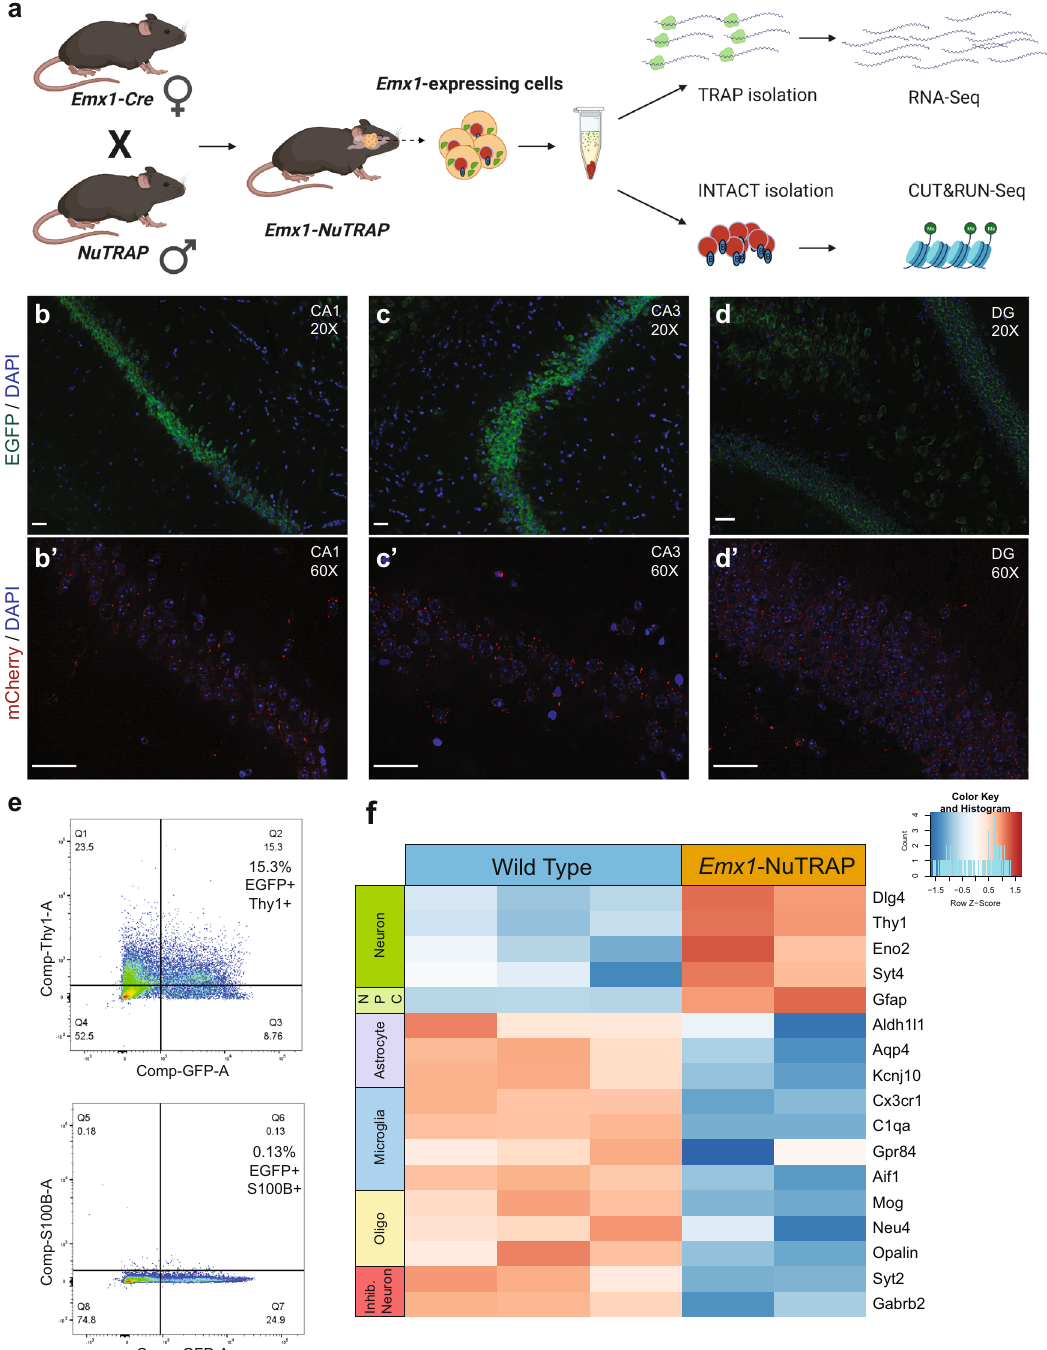
Fig. 1 Generation and validation of the Emx1-NuTRAP mouse as a tool for generating sequencing-grade, neuron-speci fi c DNA and translating mRNA from a single hippocampal homogenate. a Schematic representation of the Emx1-NuTRAP mouse generation and work fl ow of the Simultaneous INTACT and TRAP ( “ SIT ” ) protocol. Created with BioRender.com. b Immuno fl uorescence imaging of the CA1 region of the hippocampus at ×20 objective